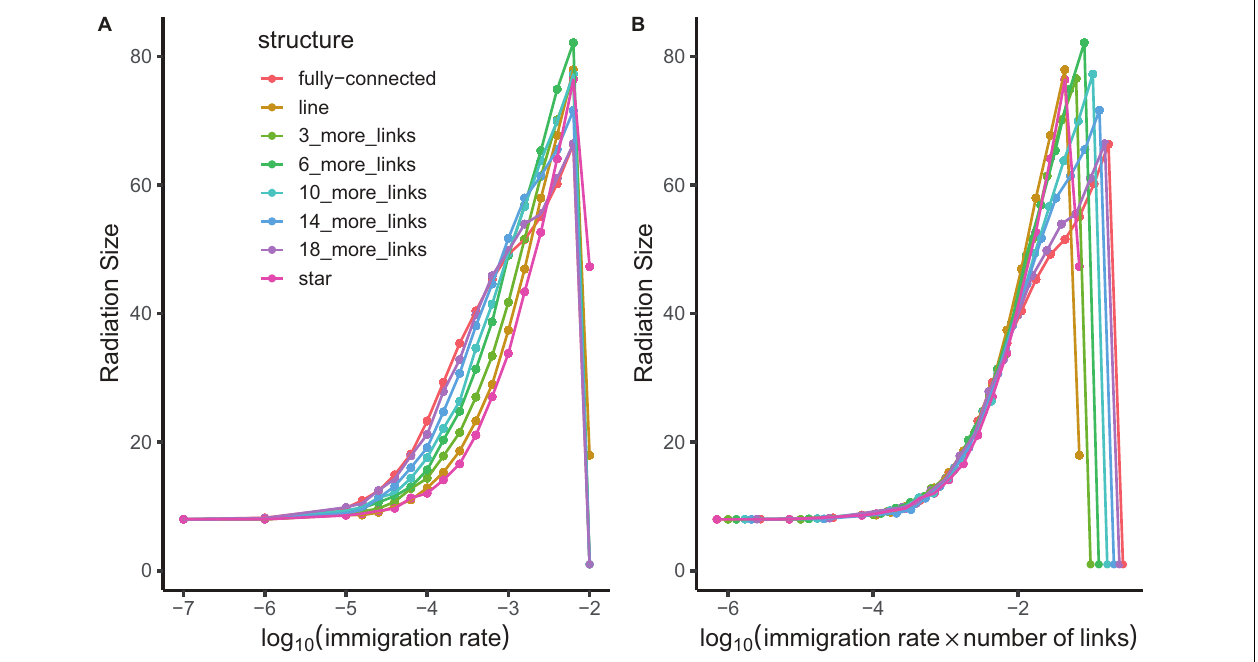
FIGURE 8 | Mean radiation size of a single lineage in a community network as a function of internal immigration rate (m) on log 10 scale. Results show a broad range of connection networks with different numbers of links in different colors. Panel (A) shows the raw data. Panel (B) shows a scaling collapse based on the same data; here, the horizontal axis shows immigration rate multiplied by number of links in the network. The leftmost part of the graph for relatively low immigration rates thus has a radiation size predicted by immigration rate × number of links rather than depending independently on those two parameters. The figure was produced with gene flow effect (G) equal to 0.1 and community network containing 8 patches each with 1000 individuals.